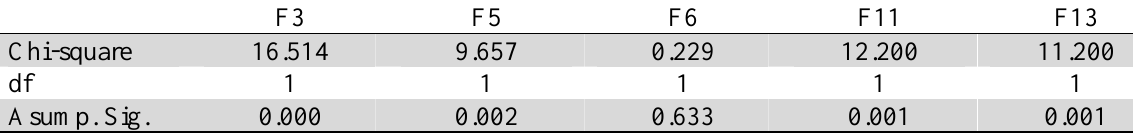
The results of Chi-Square for management type barriers F3 F5 Chi-square